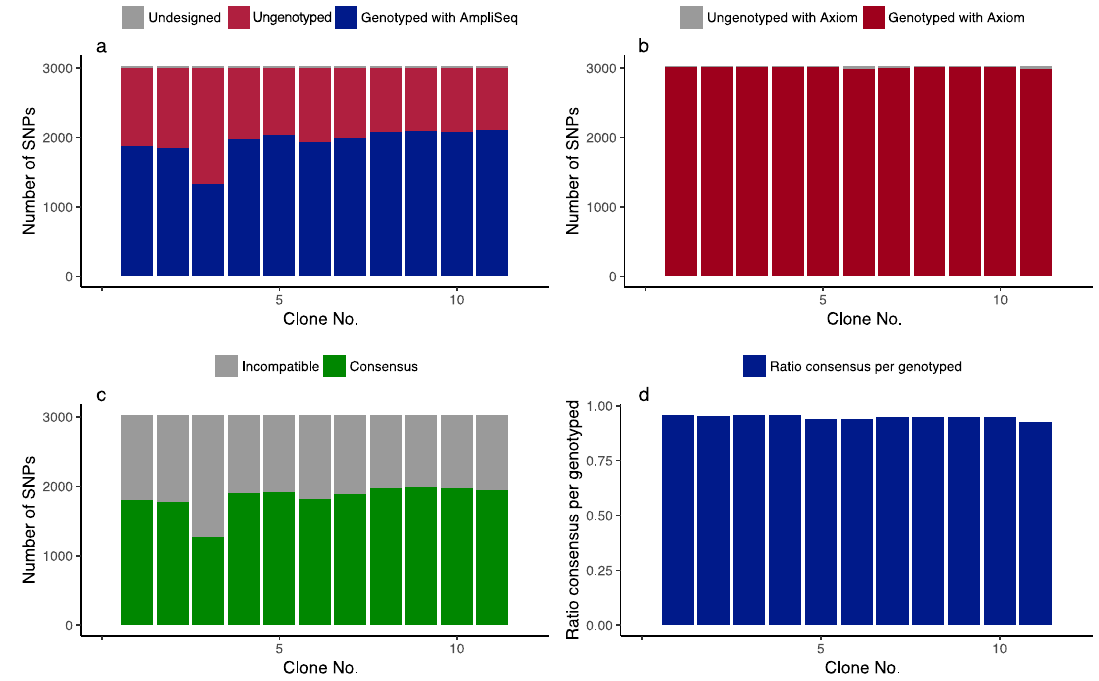
Figure 2. Parameters determined through genotyping for primary evaluation with the custom primer panel: ( a ) read depth; ( b ) read quality score; ( c ) number of variants per site; ( d ) GC ratio; and ( e ) marker position. The linkage positions of the amplicons on the linkage map in C. japonica published by Mishima et al. [36] are shown.